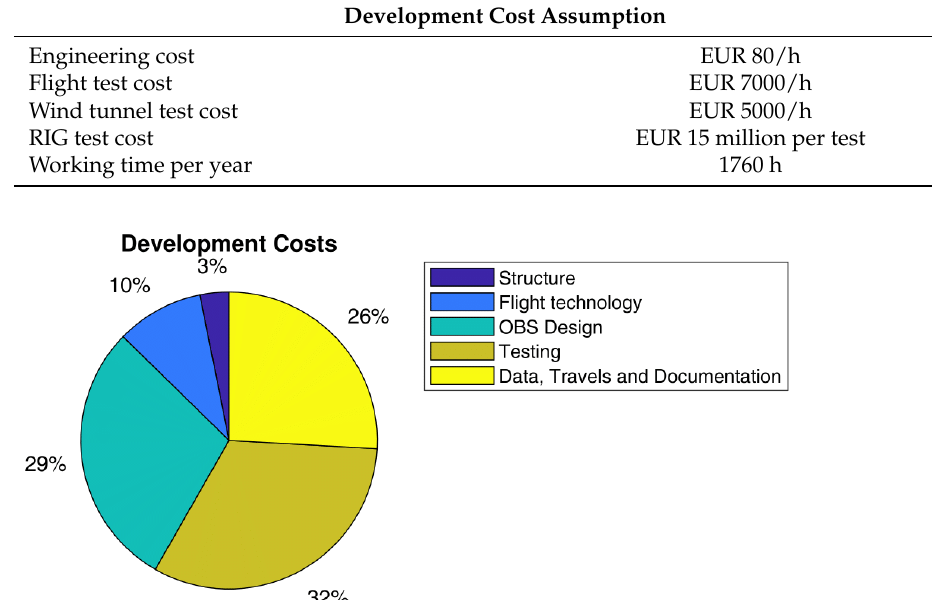
Table 4. Data assumed for computing the development costs.